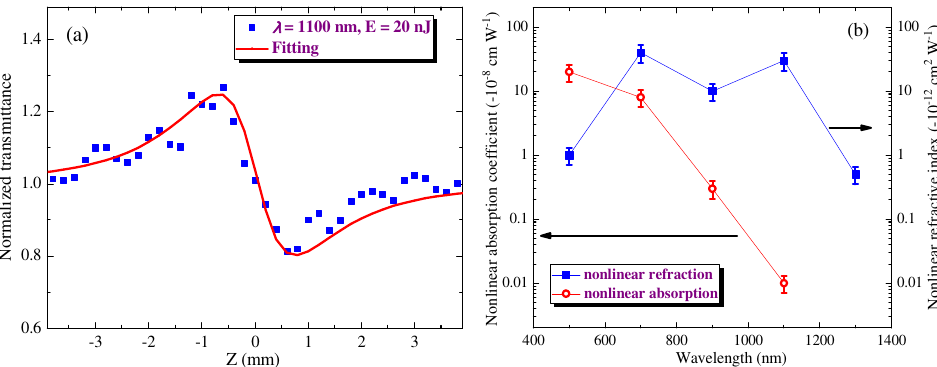
Figure 5. Analysis of the nonlinear refractive properties of the film. ( a ) CA Z-scan using 1100 nm, 20 nJ, and 150 fs probe pulses. Solid curve: fitting of CA Z-scan. ( b ) Spectral dependencies of the nonlinear refractive index (blue-filled squares) and SA-related nonlinear absorption coefficient (red, empty circles).